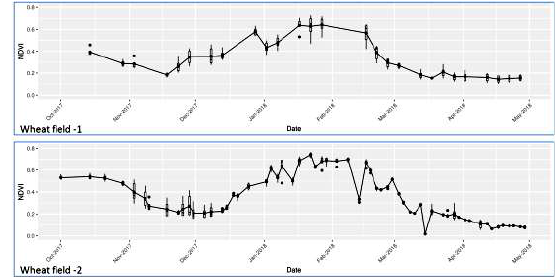
Figure 4. Raw NDVI time series observed over sample Wheat